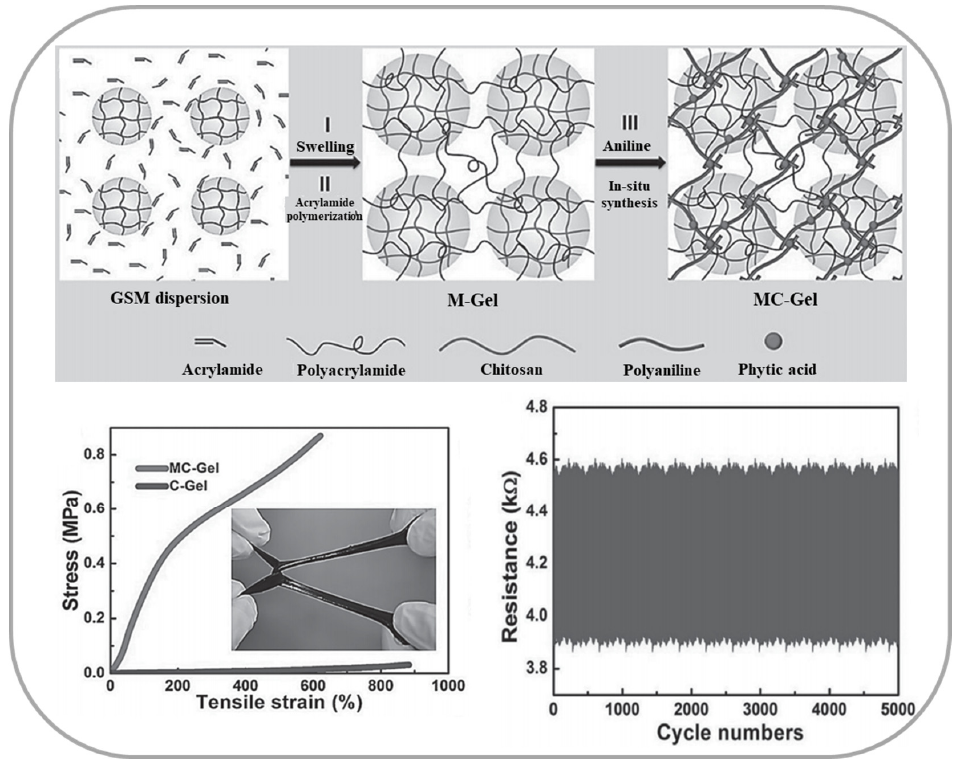
Figure 8. The schematic preparation process, mechanical property and resistance variations under 5000 cycles of the MC-Gel.